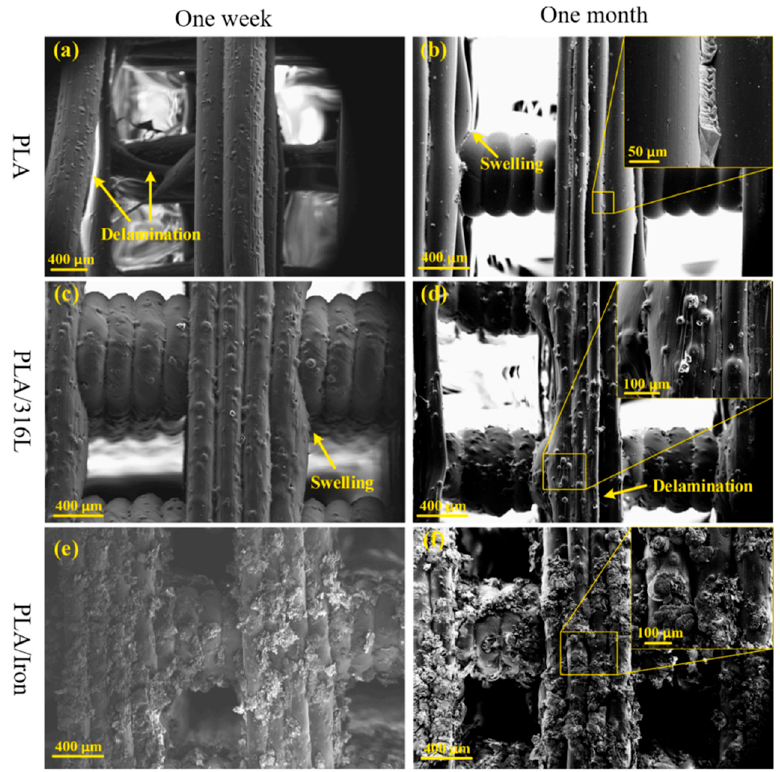
Figure 7. Surface morphology of PLA and PLA-based composite scaffolds after one week and one-month immersion in PBS solution [80].